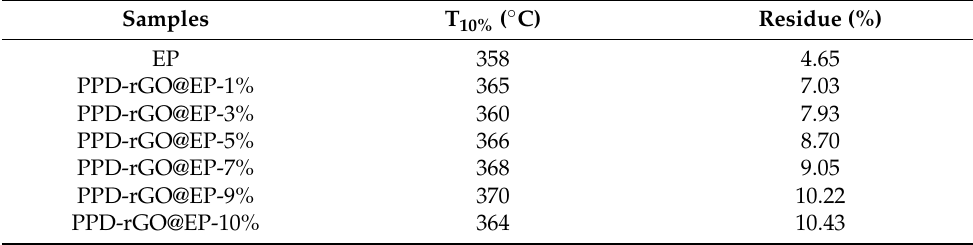
Figure 5. Thermogravimetric curves of composite materials. Table 2. Characteristic thermal parameters of composite